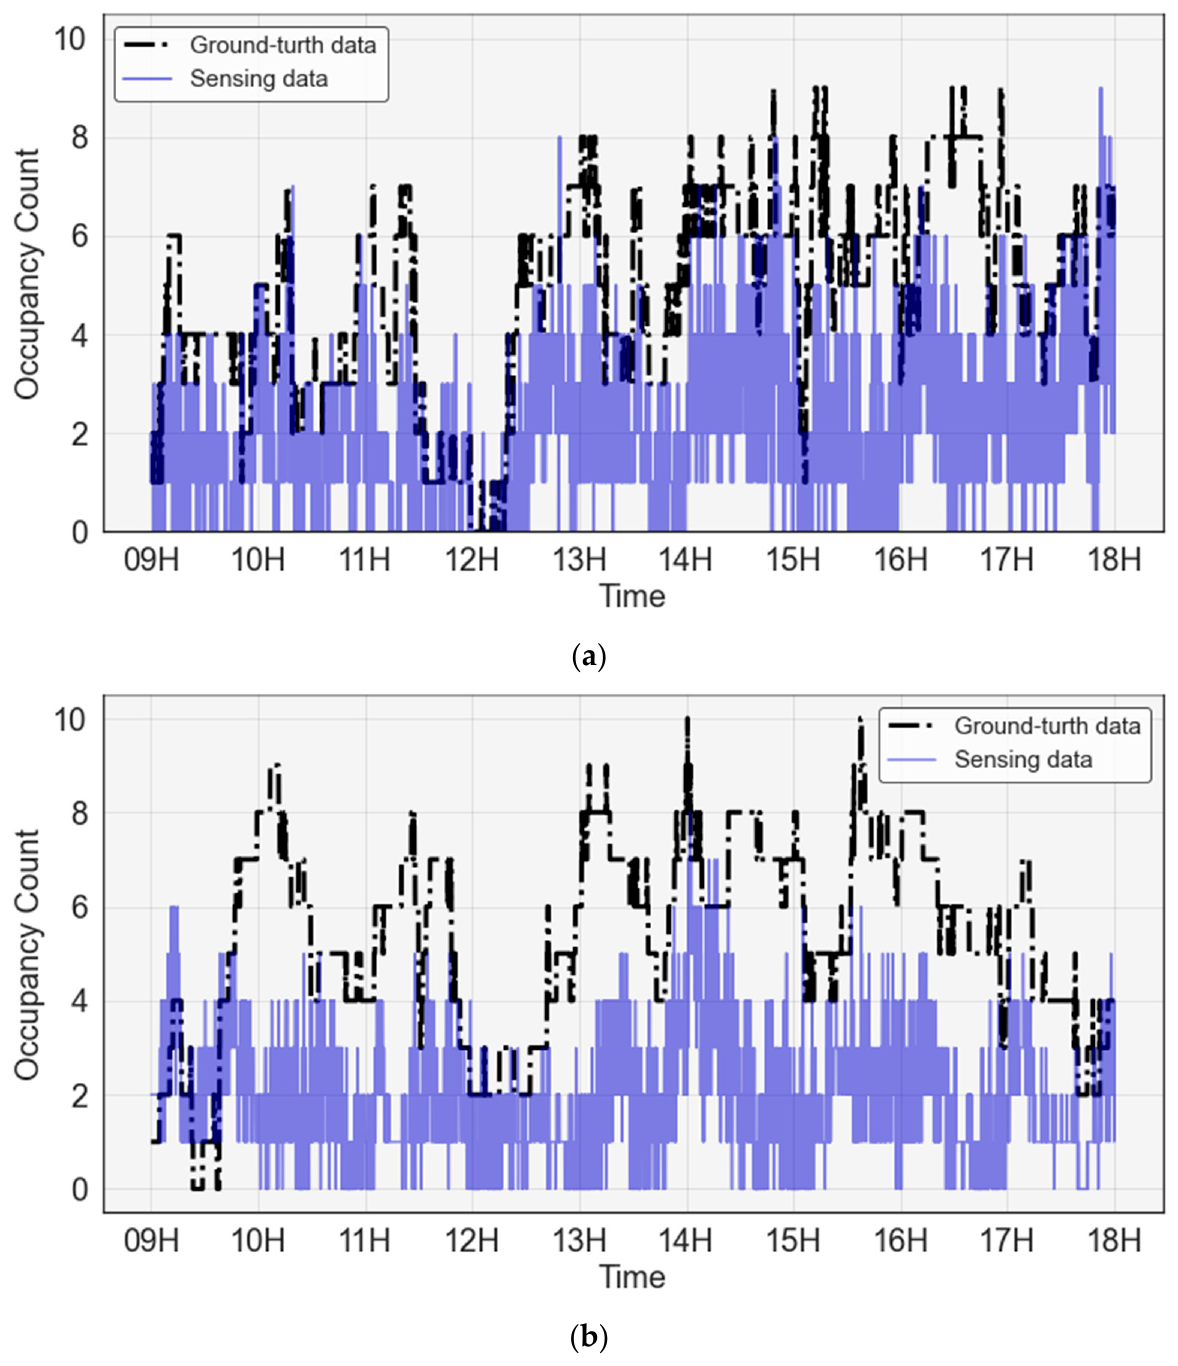
Figure 6. Sensing and ground-truth occupancy count data: ( a ) room 1; ( b ) room 2.